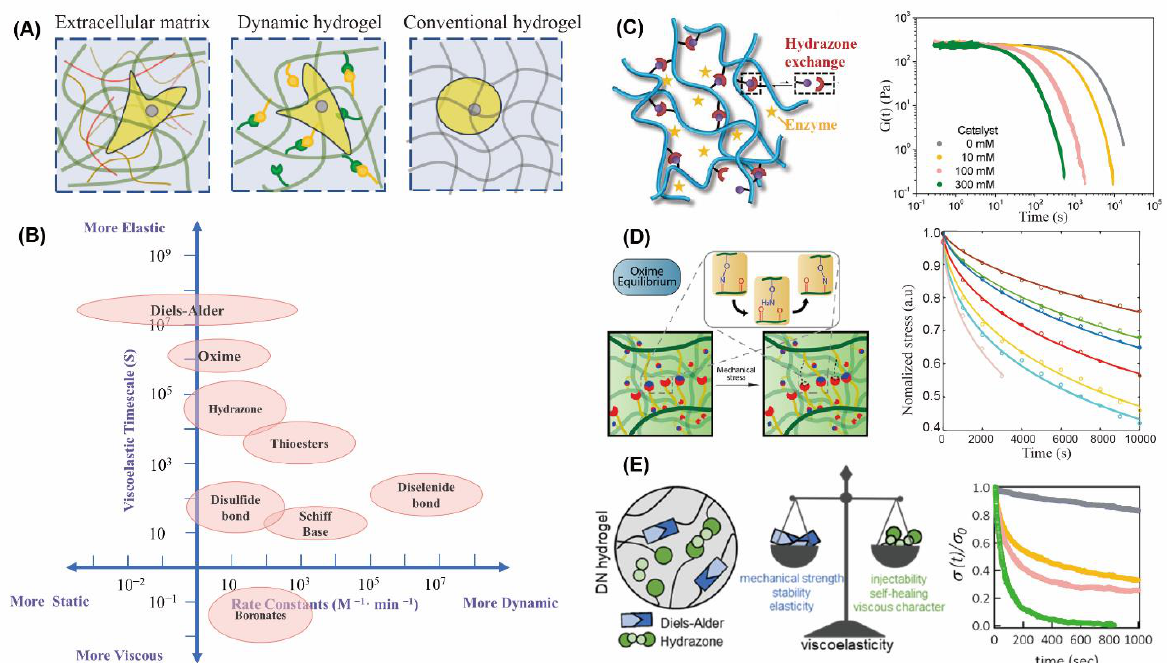
Figure 4. The dynamic covalent hydrogels enable highly tuned viscoelasticity ( A ) Similar to ECM, DCHs have viscoelasticity, in which cells can spread, migrate and proliferate, while permanent covalent network restricts cell behaviors; ( B ) dynamics and viscoelasticity of different DCCs. ( C ) The viscoelasticity of hydrogels was adjusted by decouple crosslinking density and exchange kinetics of crosslinks within organic catalysts[123]. Copyright © 2021 Wiley-VCH GmbH ( D ) The alginate hydrogels exhibited highly tunable stress relaxation and mechanical properties, which can be achieved by systematically varying the composition (concentration, polymer mixing ratios, degree of oxida- tion of NaAlg-Ald) to change crosslink density[124]. Copyright © 2019, American Chemical Society; ( E ) double network (DN) hydrogels, containing Diels-Alder adducts and hydrazone bonds, whose